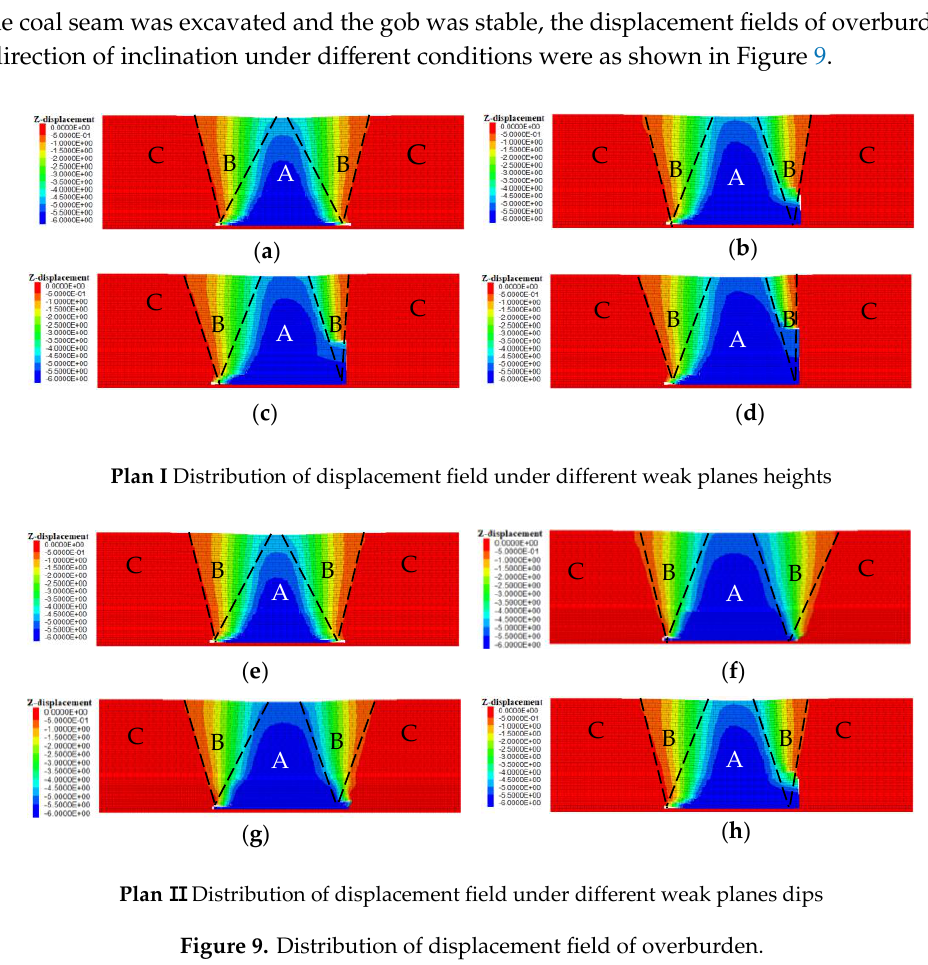
Figure 8. Numerical simulation models.